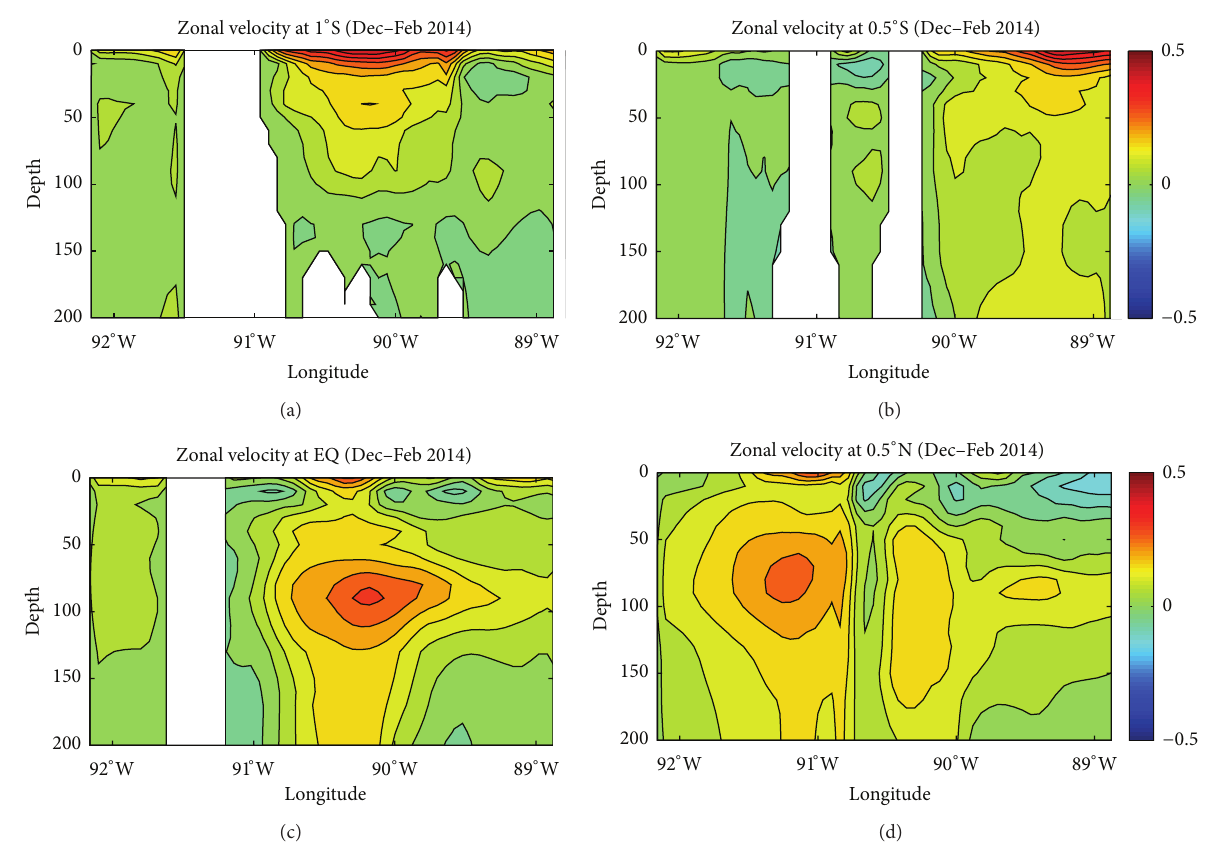
Figure 16: Vertical sections of zonal current (ms −1 ) along 1 ∘ S, 0.5 ∘ S equator and 0.5 ∘ N for the upper 200 m around the GMR in Dec–Feb 2014 El Ni˜no